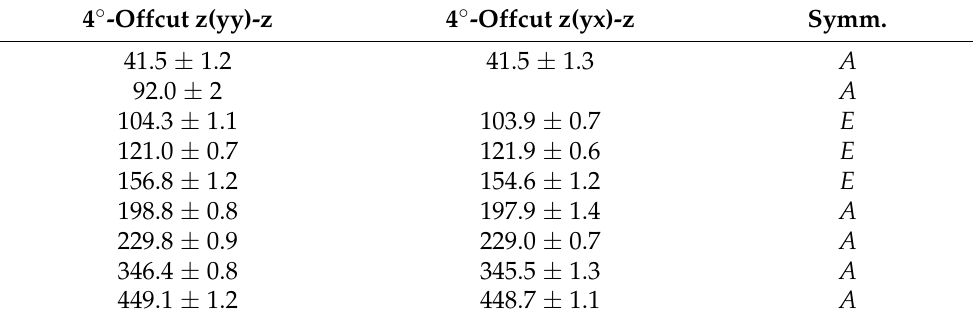
Table 1. Measured Raman frequencies (in cm − 1 ) of the Tb-reconstruction grown on 4 ◦ -offcut Si(111)